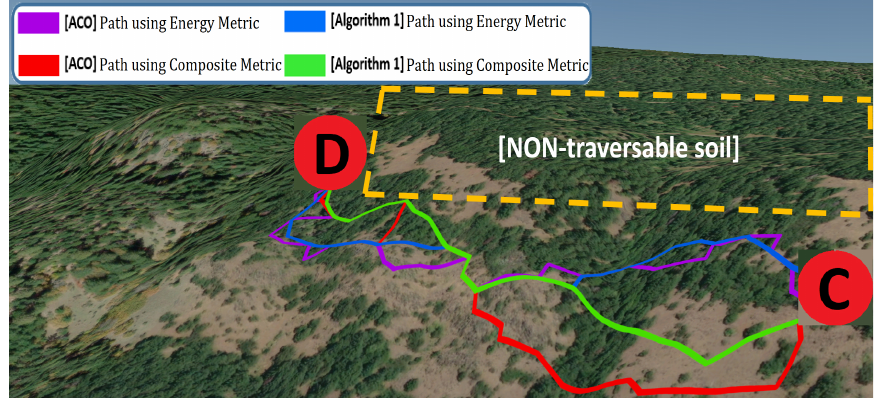
Figure 8. A 3D terrain model that displays the constructed paths from using the greedy (Algorithm 1) and ACO implementation simulation results for the [C ,D ] route pair over the real-life land under consideration in this